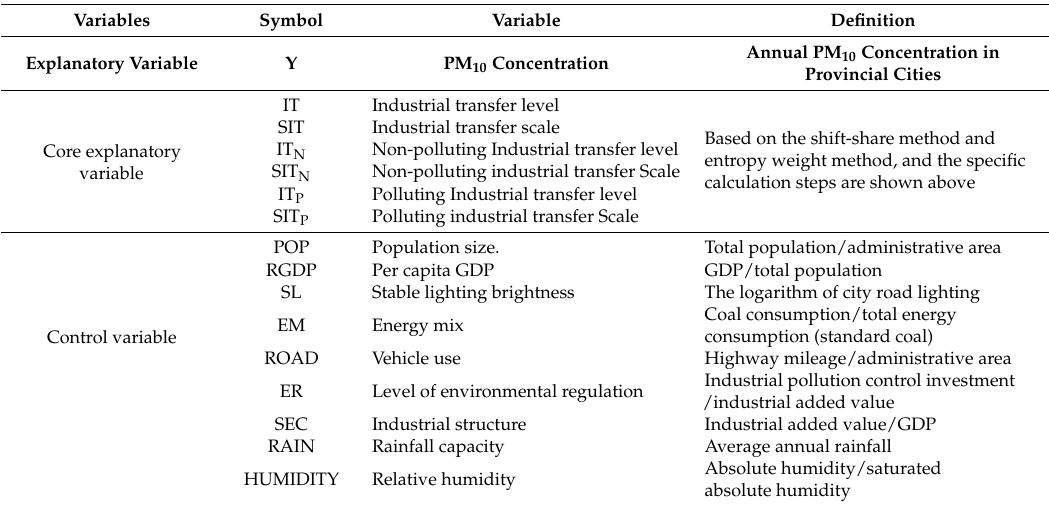
Table 2. Definition of